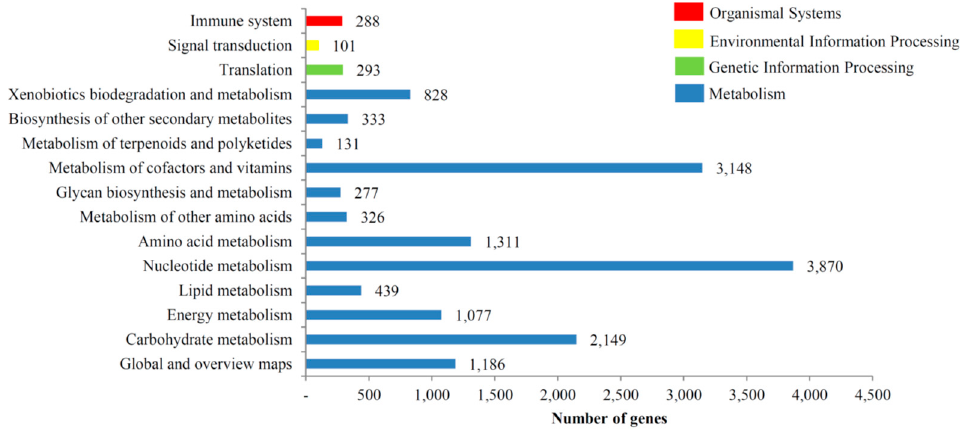
Figure 7. Identified KEGG pathways of assembled unigenes from T. longicaudatus .